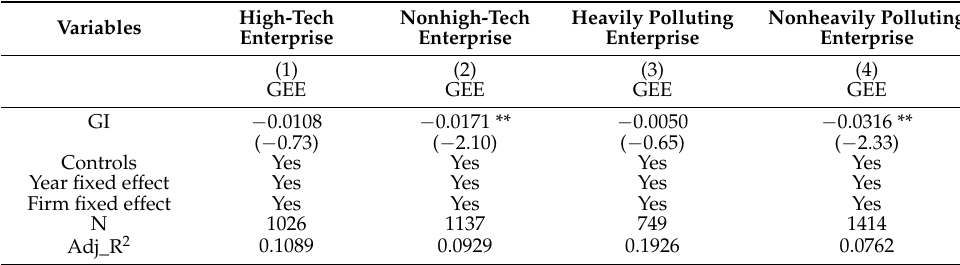
Table 7. Influence of the nature of production and operation activities of enterprises.